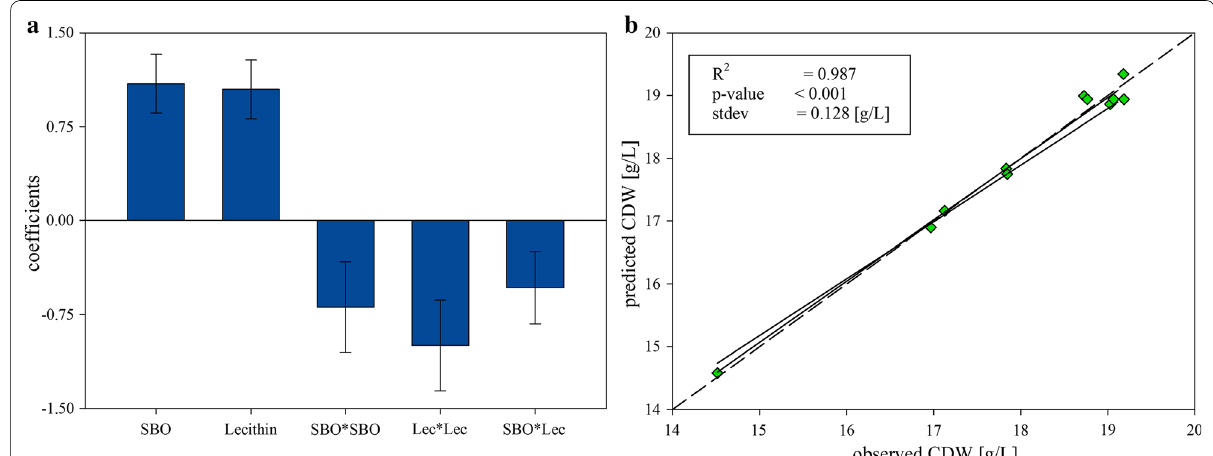
Fig. 5 The data of the 23 DoE were fitted using an MLR model. The coefficient plot (plot a ) shows that crude SBO as well as extracted lecithin positively correlate to the CDW. Nevertheless, too high concentrations seem to have a negative impact, which can be seen in the negative interaction and quadratic terms. Plot b represents the observed vs predicted plot of the model, showing a good model